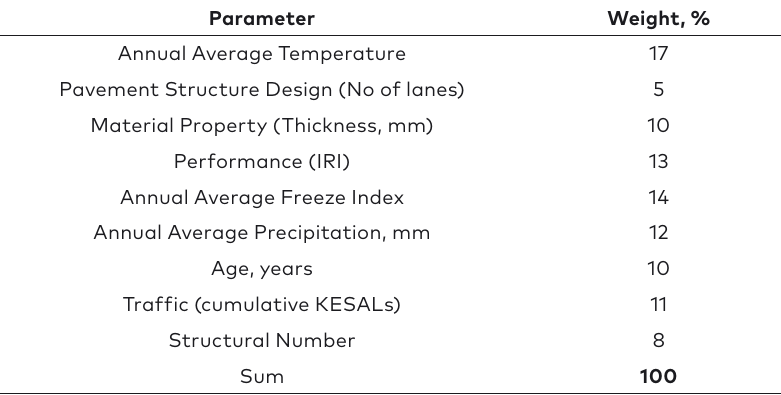
Table 6. Final parameters weights extracted from